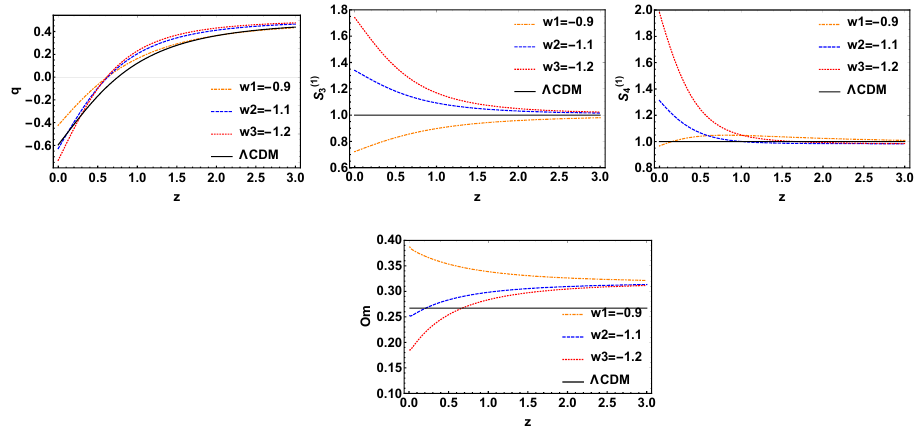
( 1 ) ( 1 ) , S and Om , respectively, versus red shift z for the 3 4